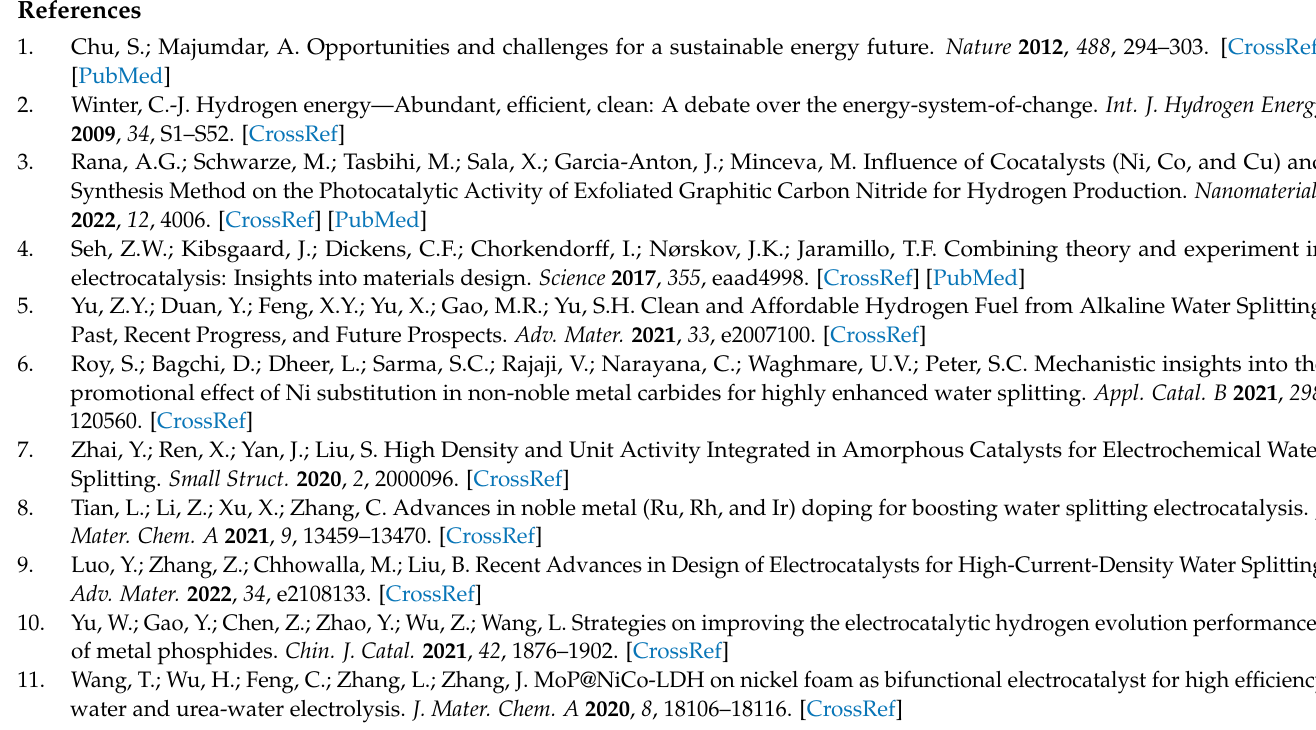
with varied scan rates of 20-100 mV s − 1 in 1.0 M KOH, Figure S10: The calculated ECSA values of synthesized catalysts, Figure S11: LSV curves normalized against ECSA, Figure S12: (a, b) SEM and (c, d) TEM images of CoP 2 -Mo 4 P 3 /NF catalyst after OER stability experiment, Table S1: EIS parameters of synthesized catalysts in 1.0 M KOH for HER, Table S2: EIS parameters of